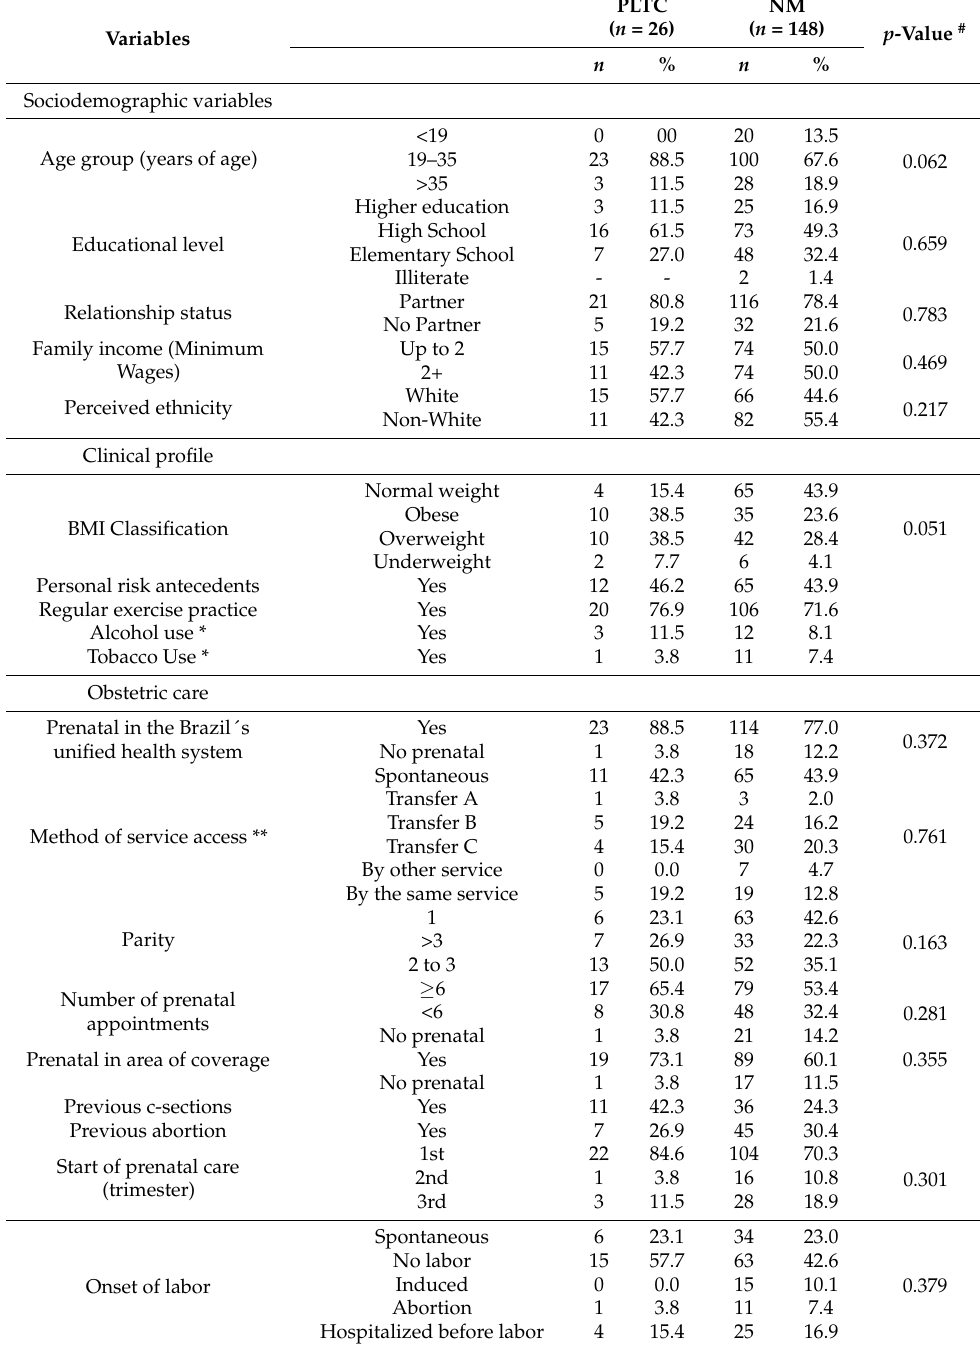
Table 1. Distribution of number and percentage of women in potentially life-threatening conditions (PLTC) and near misses (NM) according to sociodemographic characteristics and clinical-obstetric profile in the period between July 2013 and December 2015. Brasilia, Federal District, Brazil. PLTC ( n = Variables